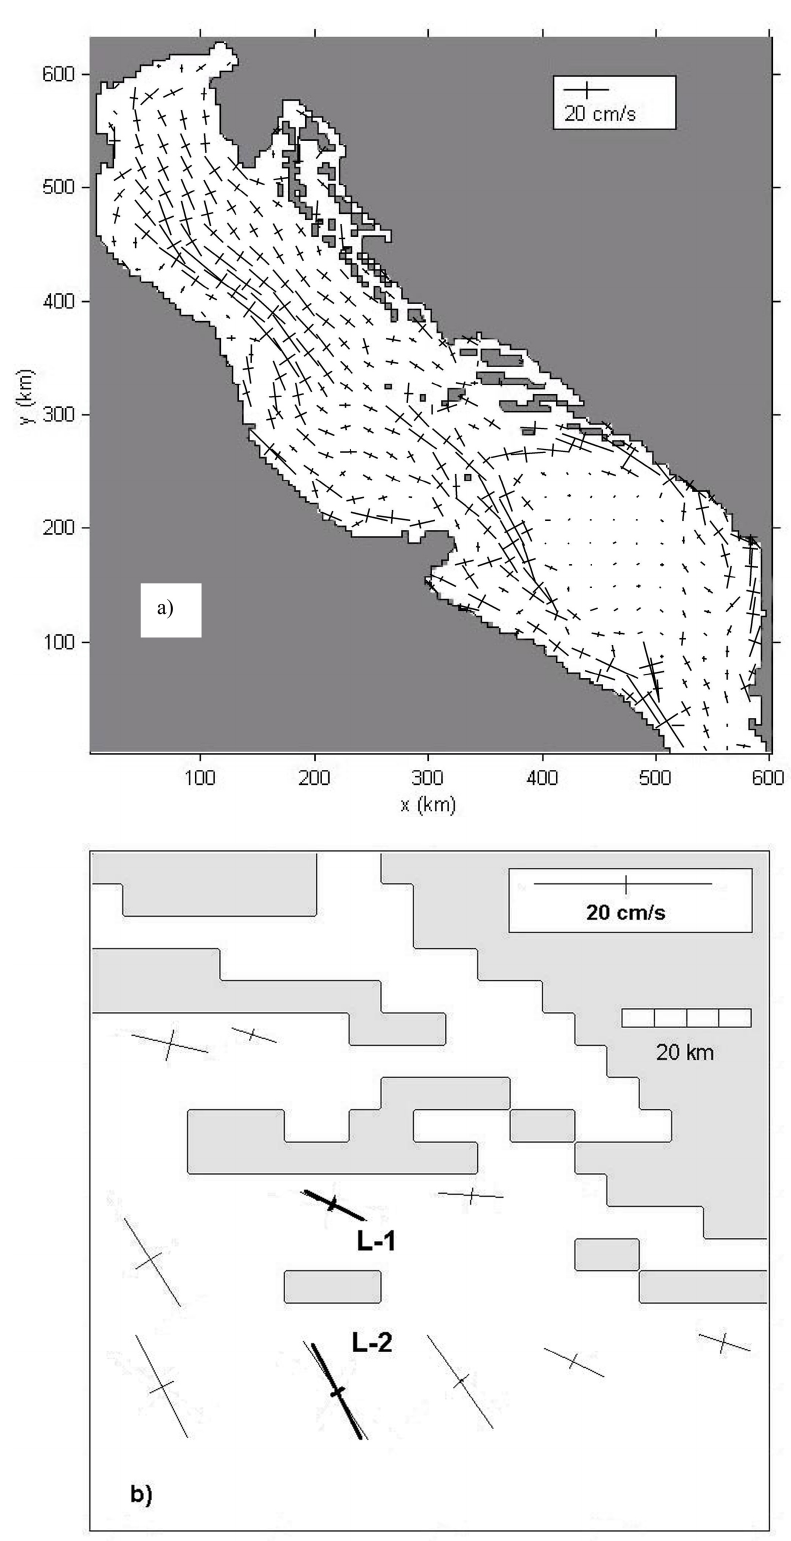
Fig. 13. Model-calculated depth-averaged residual currents presented in the form of 21-h ellipses and plotted at every fifth point of the model grid for (a) the Adriatic Sea and (b) the wider area of stations L-1 and L-2. Thick lines in the lower figure show the ellipses recorded at stations L-1 (20m) and L-2 (3m); the ellipses depicted in this figure were slightly shifted in order to achieve clarity of